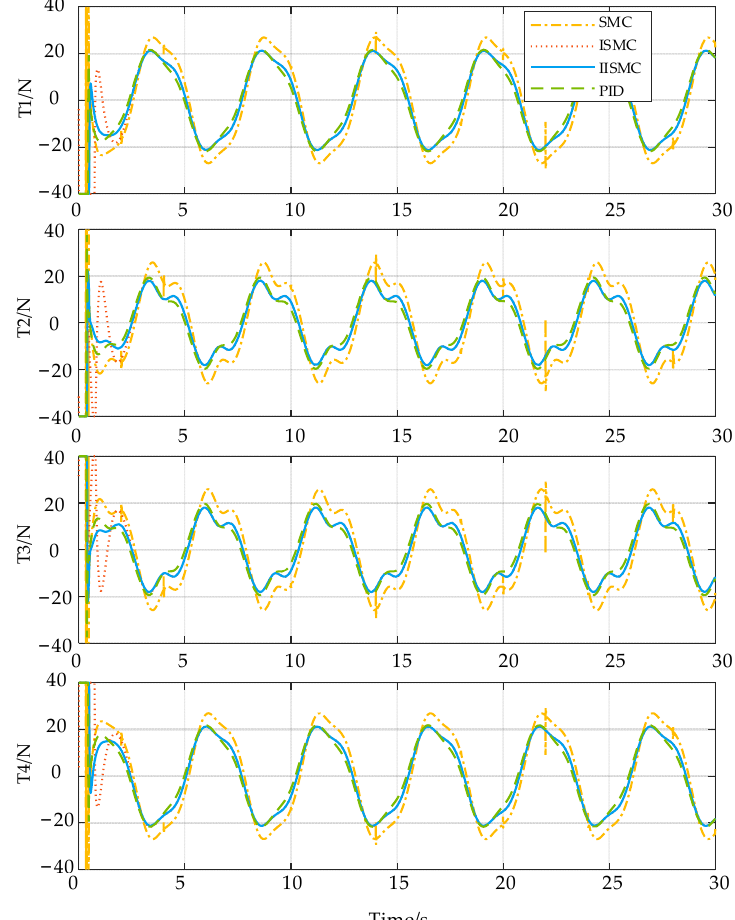
Figure 18. The thrust force curve of four heave thrusters in Scene 4.